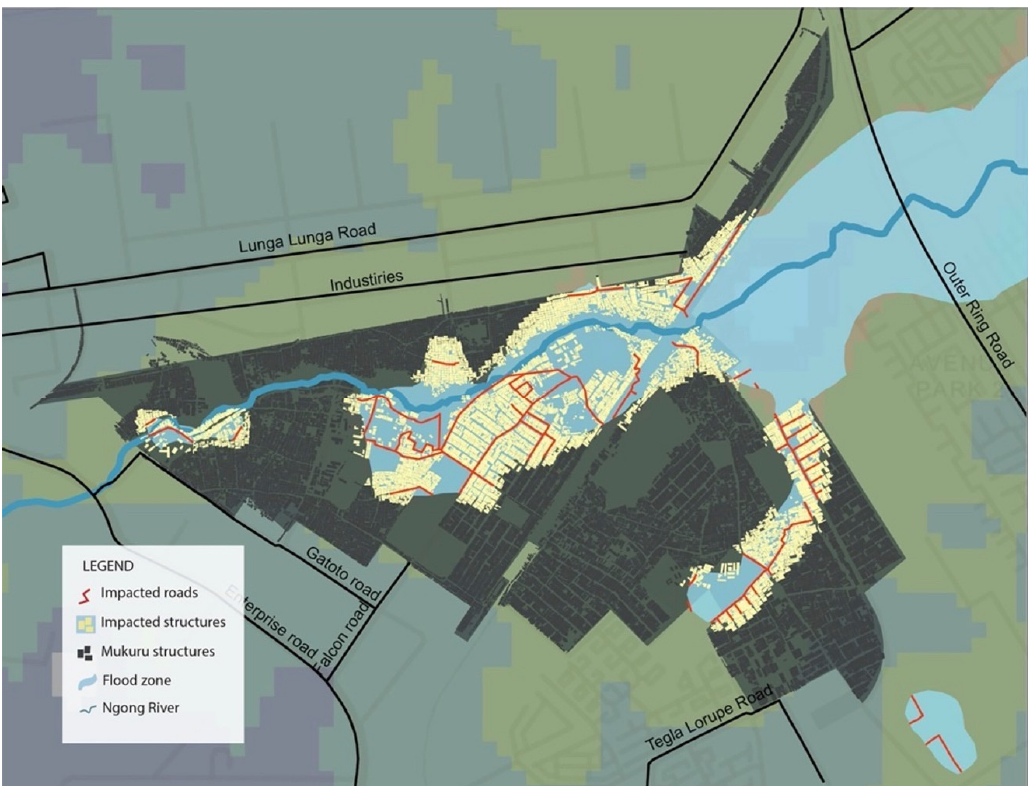
Figure 5. Estimated Mukuru Flood Zone and Impacted